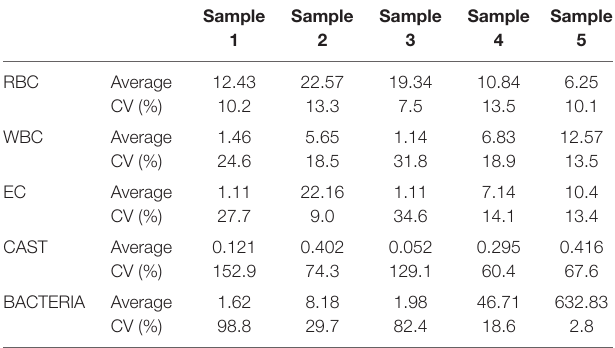
TAble 1 | Precision of the UF-1000i.